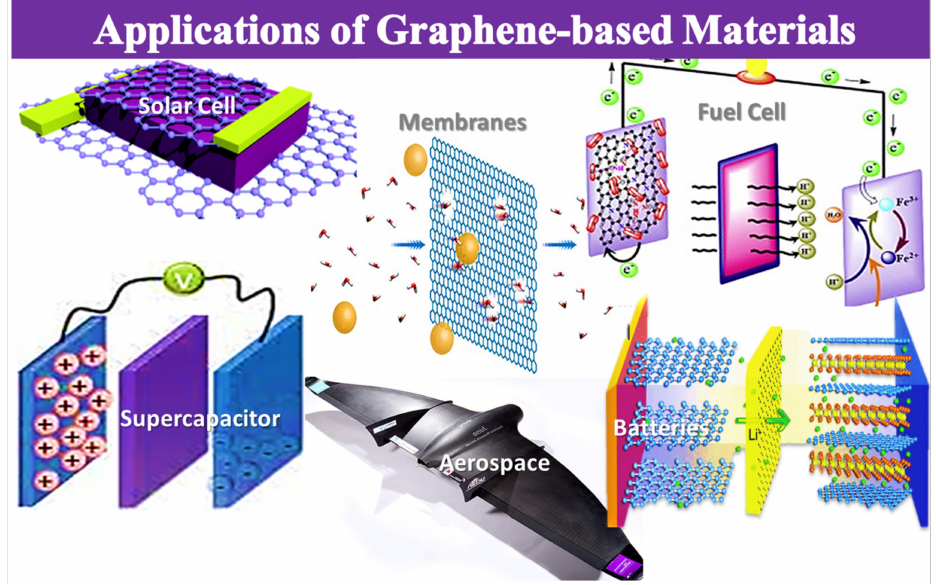
Figure 11. Applications of polymer/graphene